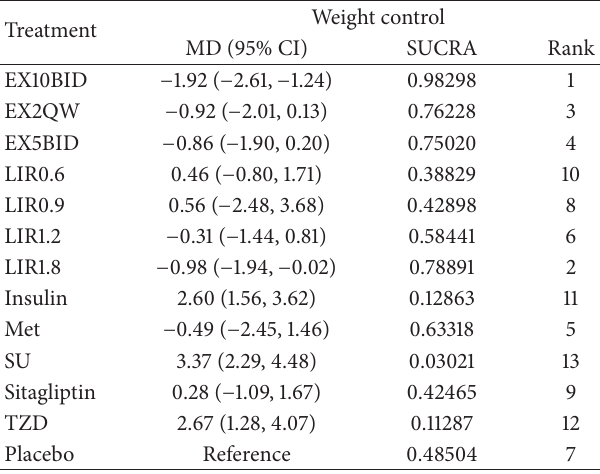
Table 3: Mean differences of weight and the rank of GLP-1 RAs on weight loss in comparison with